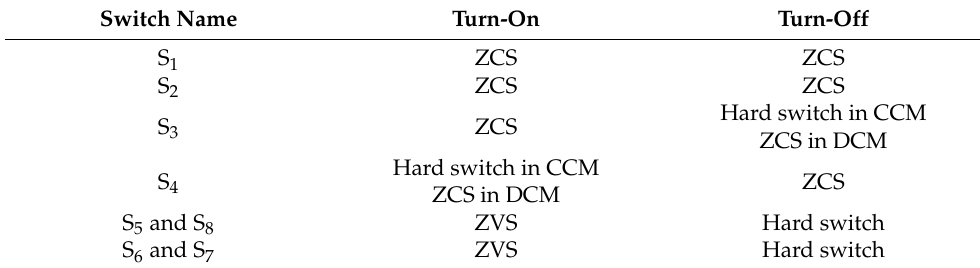
Table 1. The soft switching characteristics of switches.